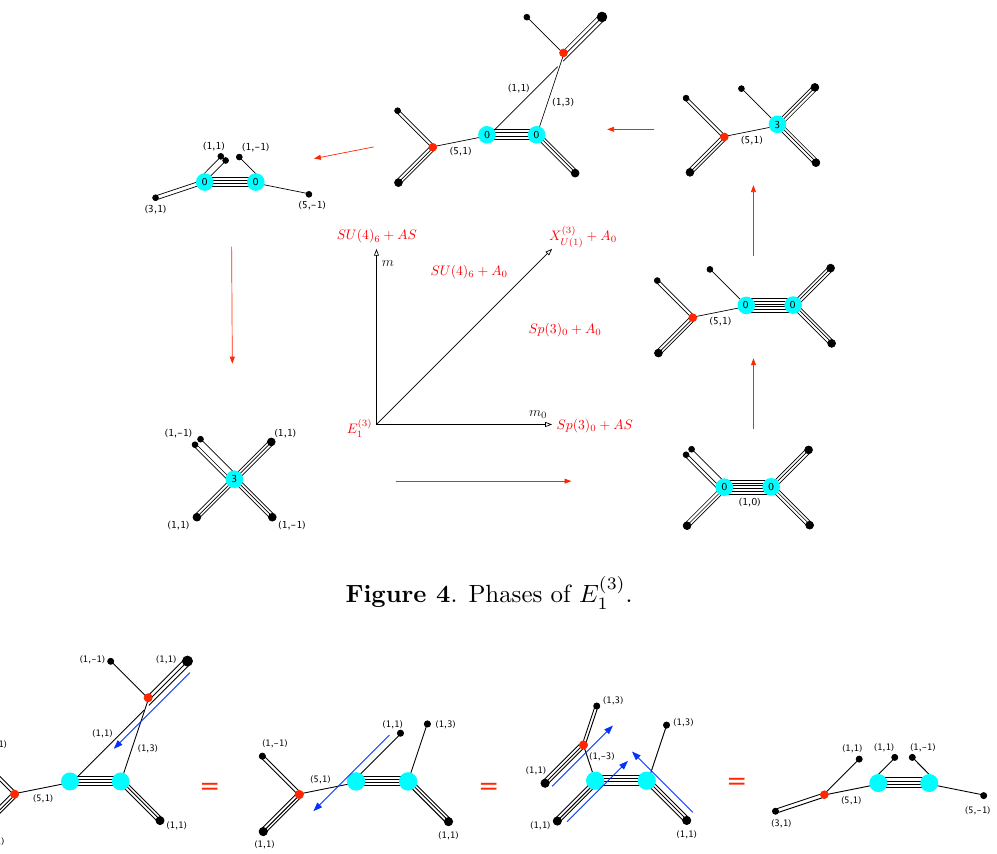
Figure 5 . Equivalent 5-brane webs for SU(4) 6 with a massive antisymmetric